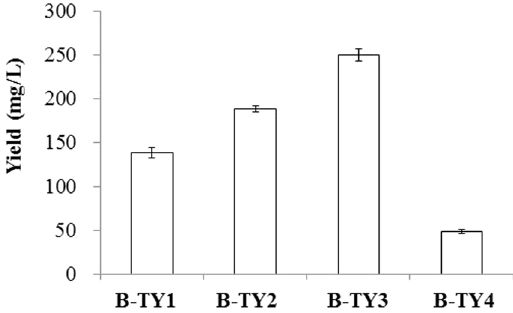
Figure 3. Effect of different E. coli strain on the production of tyrosol. B-TY1, wild type harboring AAS ; B-TY2, tyrR and pheA deletion mutant harboring AAS; B-TY3, tyrR , pheA , and feaB deletion mutant harboring AAS; B-TY4, wild type harboring TDC and TYO.